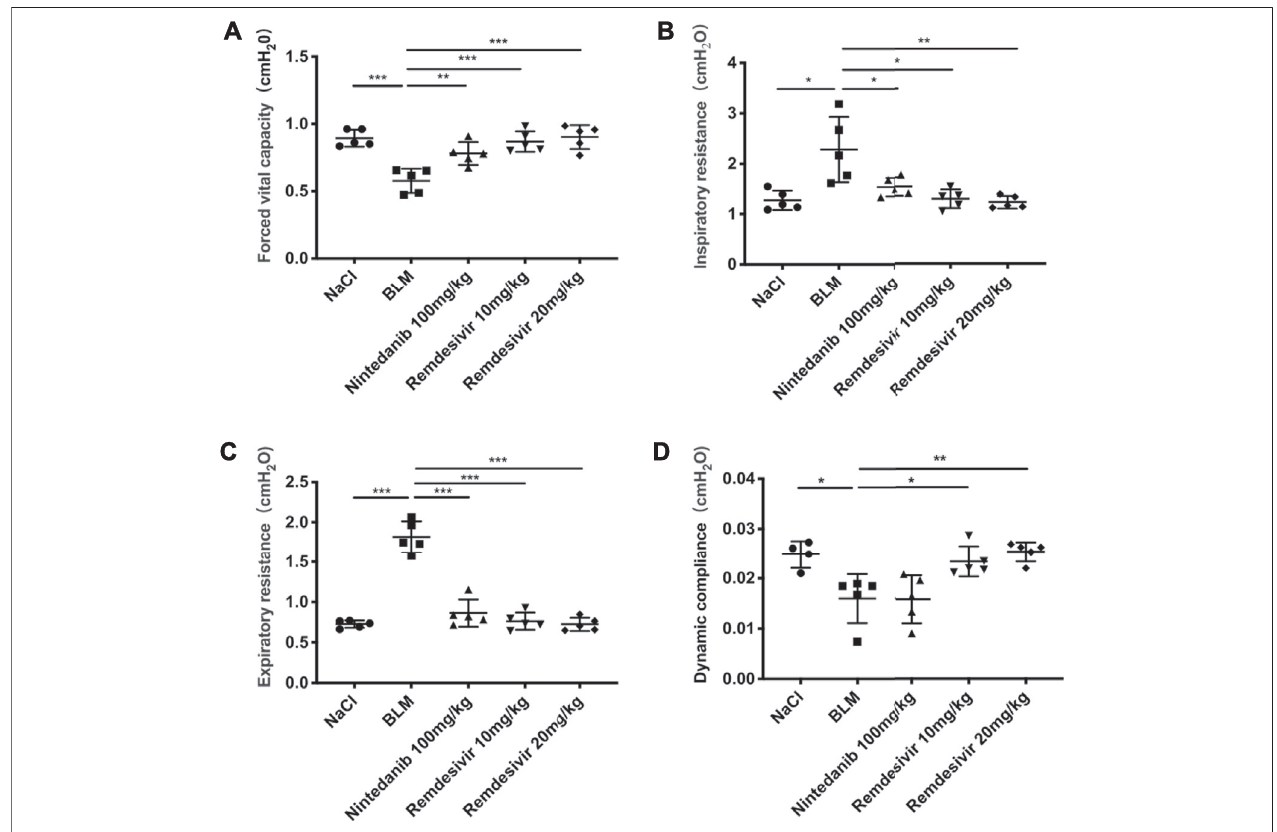
FIGURE 2 | Remdesivir improves pulmonary function in BLM-treated mice. (A) Forced vital capacity of mice. (B) Inspiratory resistance of mice. (C) Expiratory resistance of mice. (D) Dynamic compliance of mice. Data was noted as the means ± SD, n (cid:1) 5. * p < 0.05, ** p < 0.01, *** p < 0.001, **** p < 0.0001.